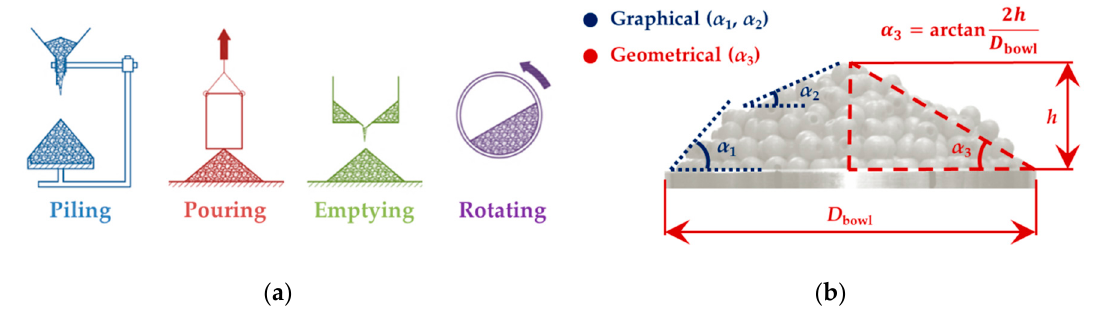
Figure 5. Angle of repose calibration: ( a ) pile formation methods; ( b ) AoR (angle of repose) evaluation methods.